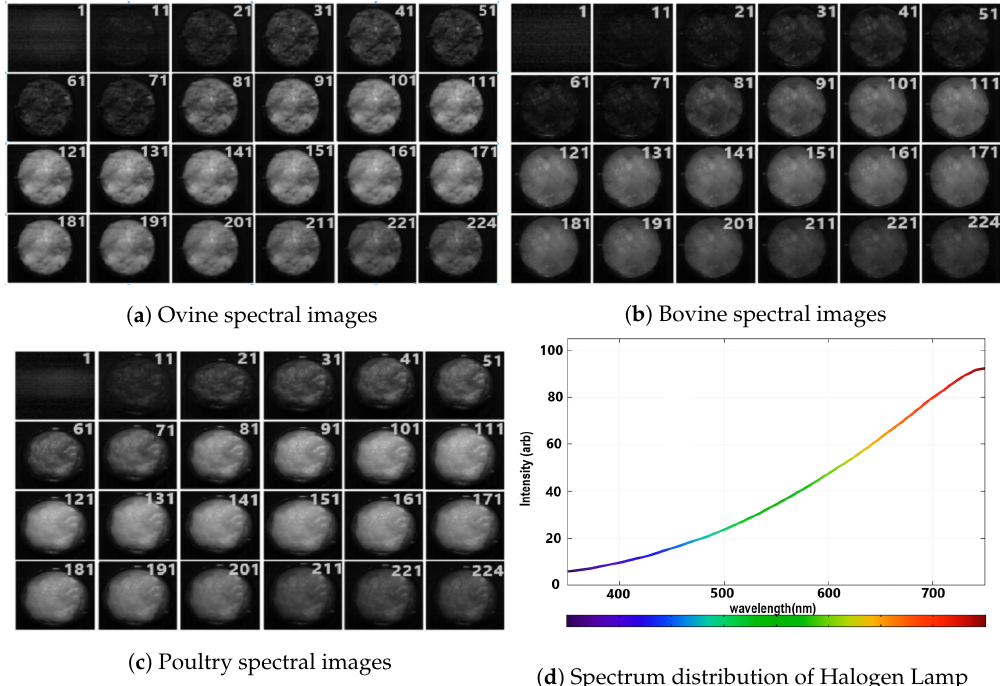
Figure 5. The entire electromagnetic spectrum of minced meat type. ( a ) Ovine spectral images; ( b ) Bovine spectral images; ( c ) Poultry spectral images; ( d ) spectrum distribution of halogen lamp. True-color image contains the information about samples similar to what is collected by the human visual system. The correlation coefficient is used widely to compute the true-color images for remote sensing data [45]. For this study the segmented regions (such as θ R (Red), θ G (green) and θ B (blue)) have been examined for each band. The reflectance values are used to compute the correlation values. The highest value represents the most important wavelength in the segmented region; e.g., for Bovine minced meat, 492, 569 and 688 nm bands were selected based on the correlation values, as shown in Table